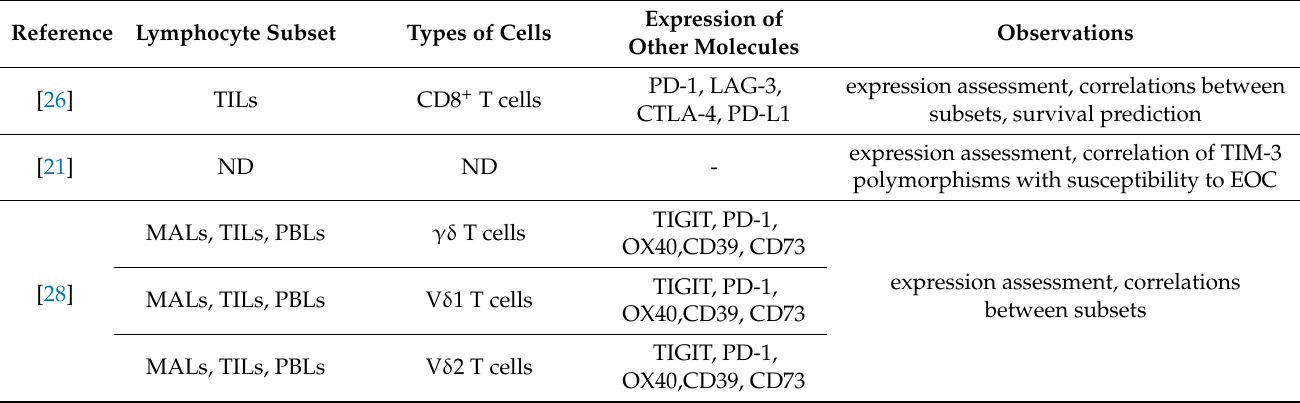
Table 1. TIM-3 expression on tumor-associated immune cells and study observations related to